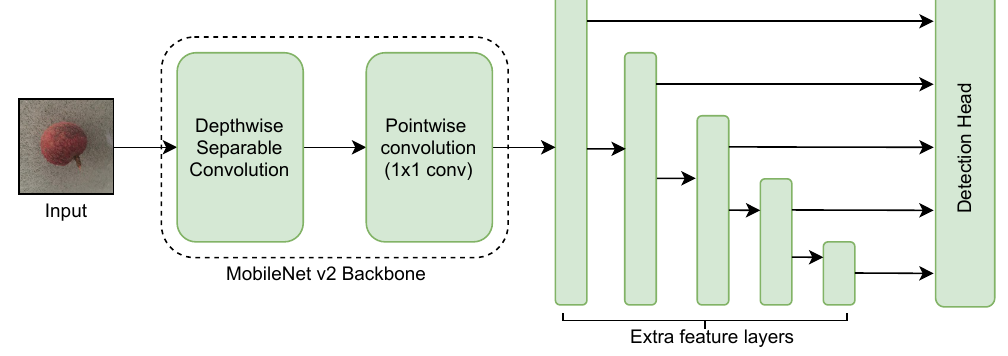
Figure 4. Neural architecture of SSD-MobileNet